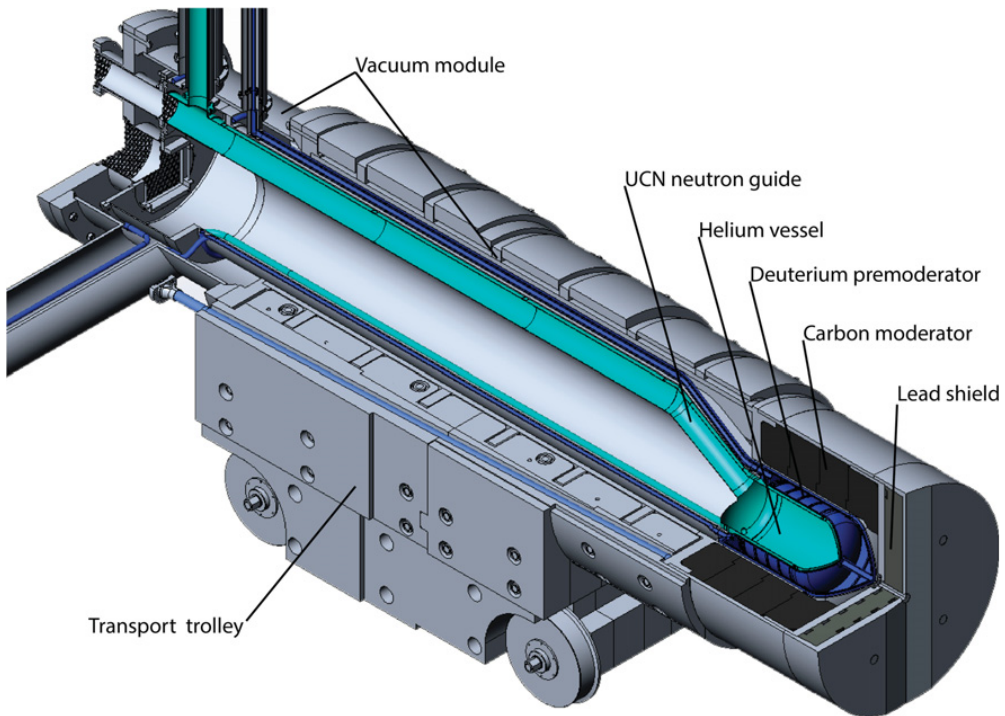
Figure 9. The UCN source assembled on its transport